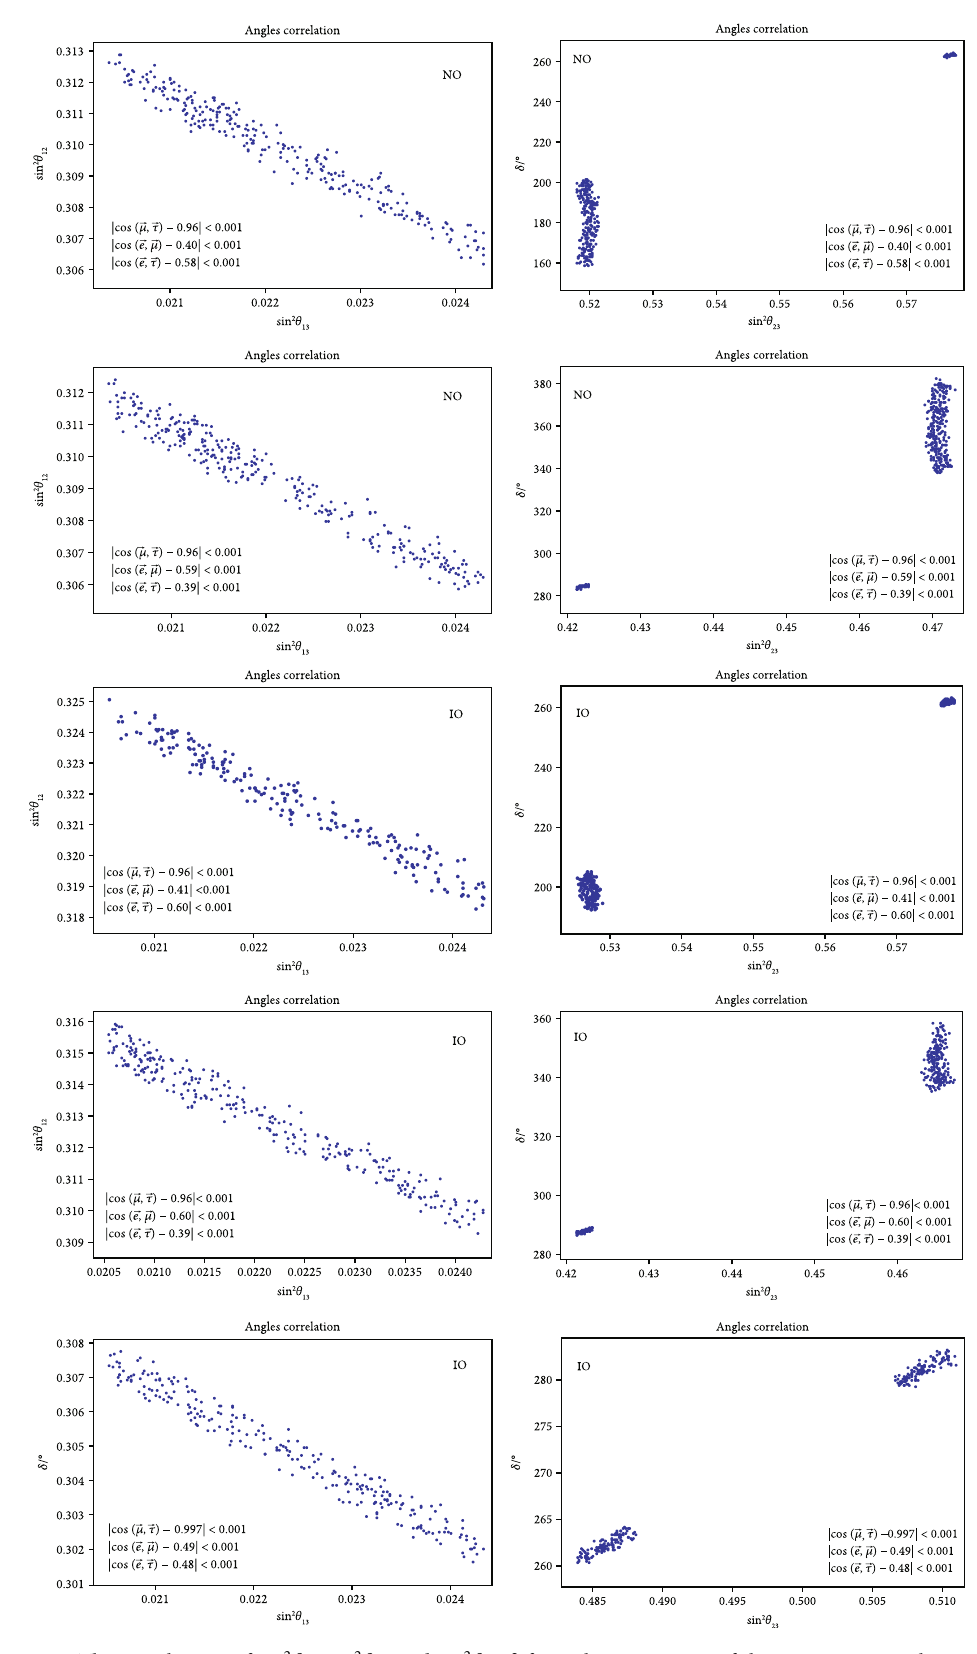
- sin 2 θ and sin 2 θ - δ from the constraints of the geometric correlations 13 12 23